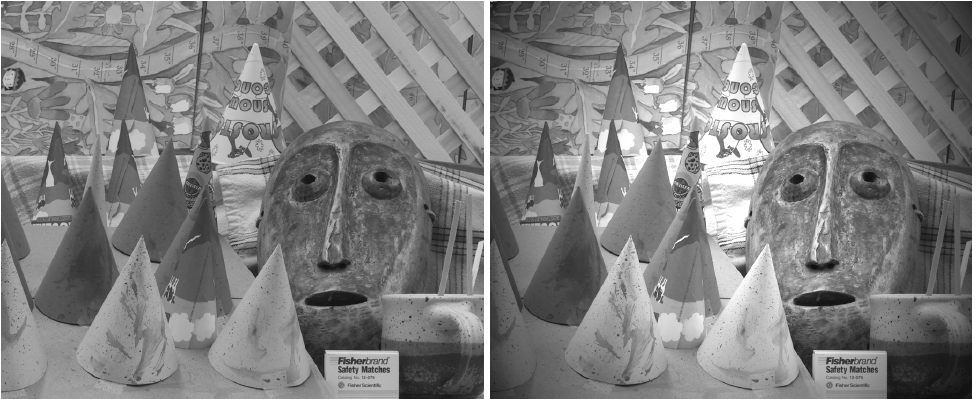
Figure 3. Cone dataset original ( left ) and with FPN ( right